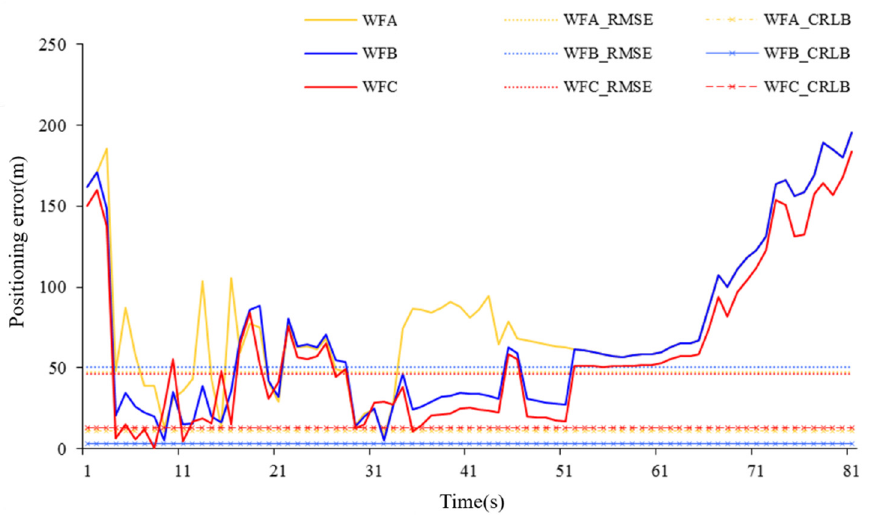
Figure 13. Comparing fusion positioning accuracy.